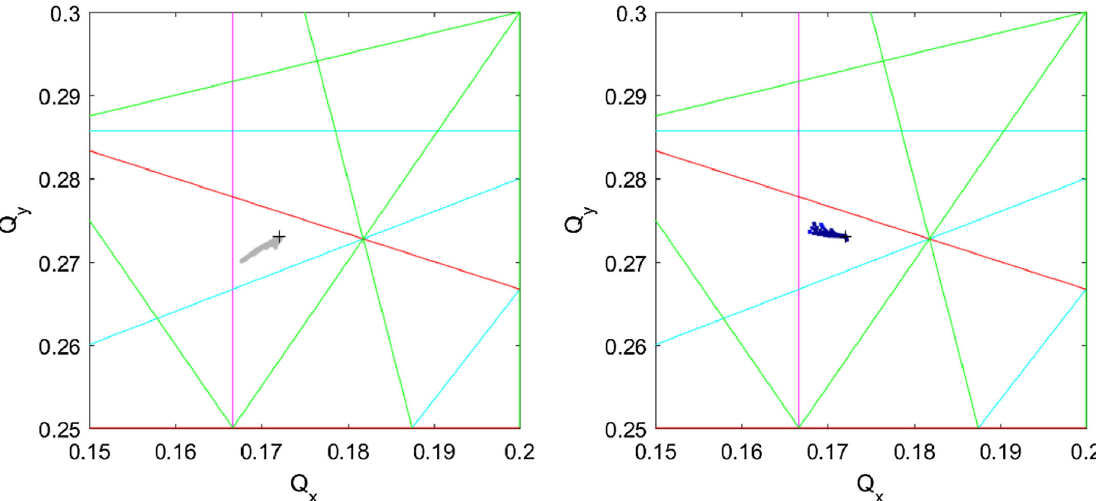
FIG. 5. Comparison between frequency maps measured on the machine (left) and computed from the model (right) over the measured dynamic aperture. The nominal tune-point is marked as ‘ þ ’